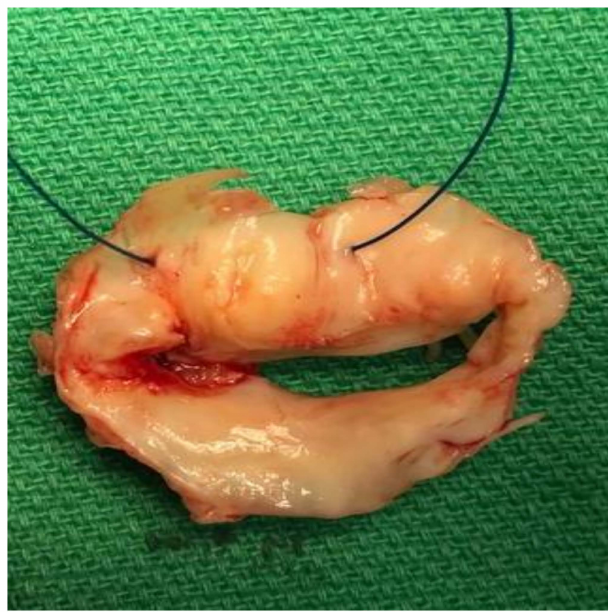
Figure 2. A picture of the excised mitral valve showing vegetations on the anterior leaflet and posterior commissure. No leaflet